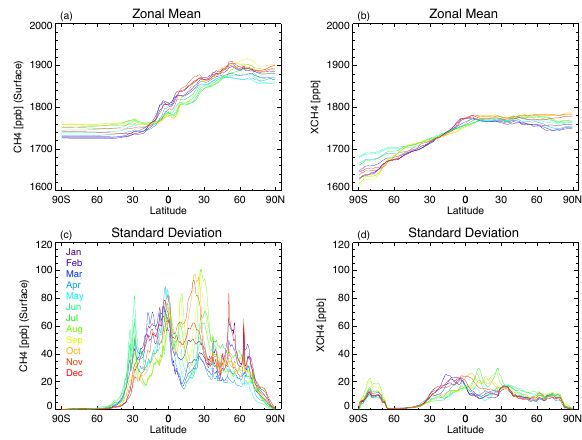
Fig. 13. Same as Fig. 11, but for CH 4 and XCH 4